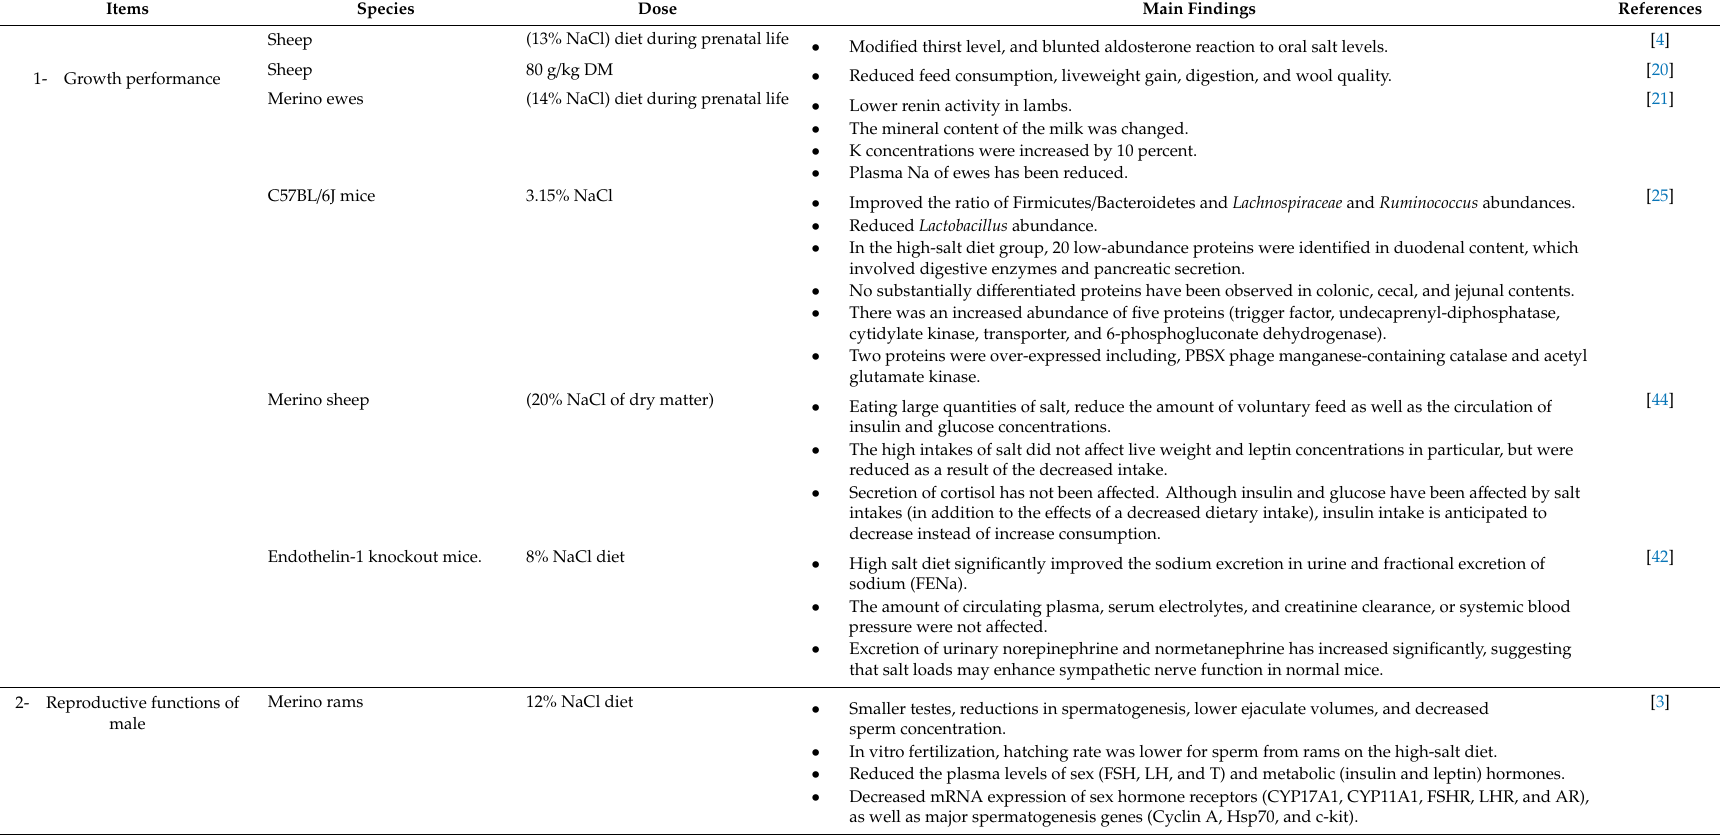
Table 1. Impacts of high salt diets on